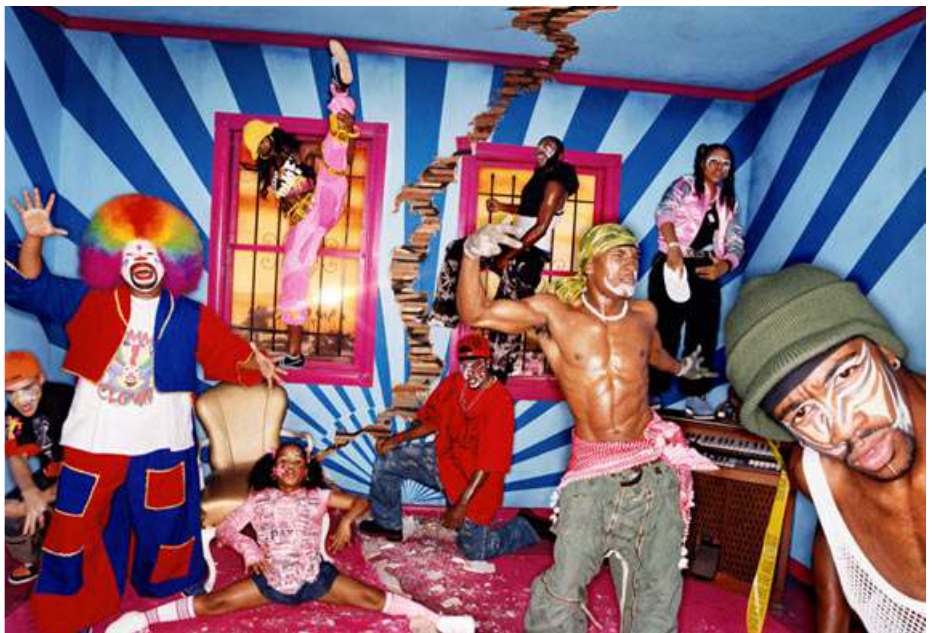
This image is one of the 15 photos that compose the album related to the fi lm on the director’s of fi cial website Source: http://www.davidlachapelle.com/ fi lm/rize/?ss=images [no longer